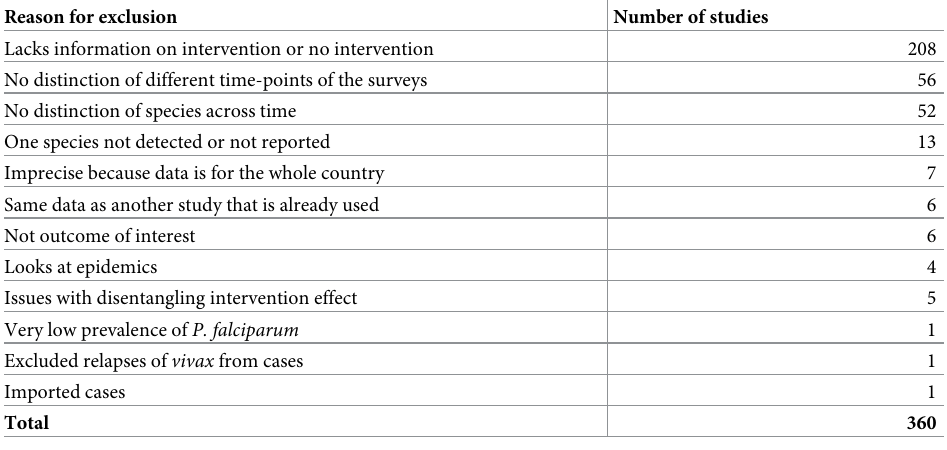
Table 1. Reasons for